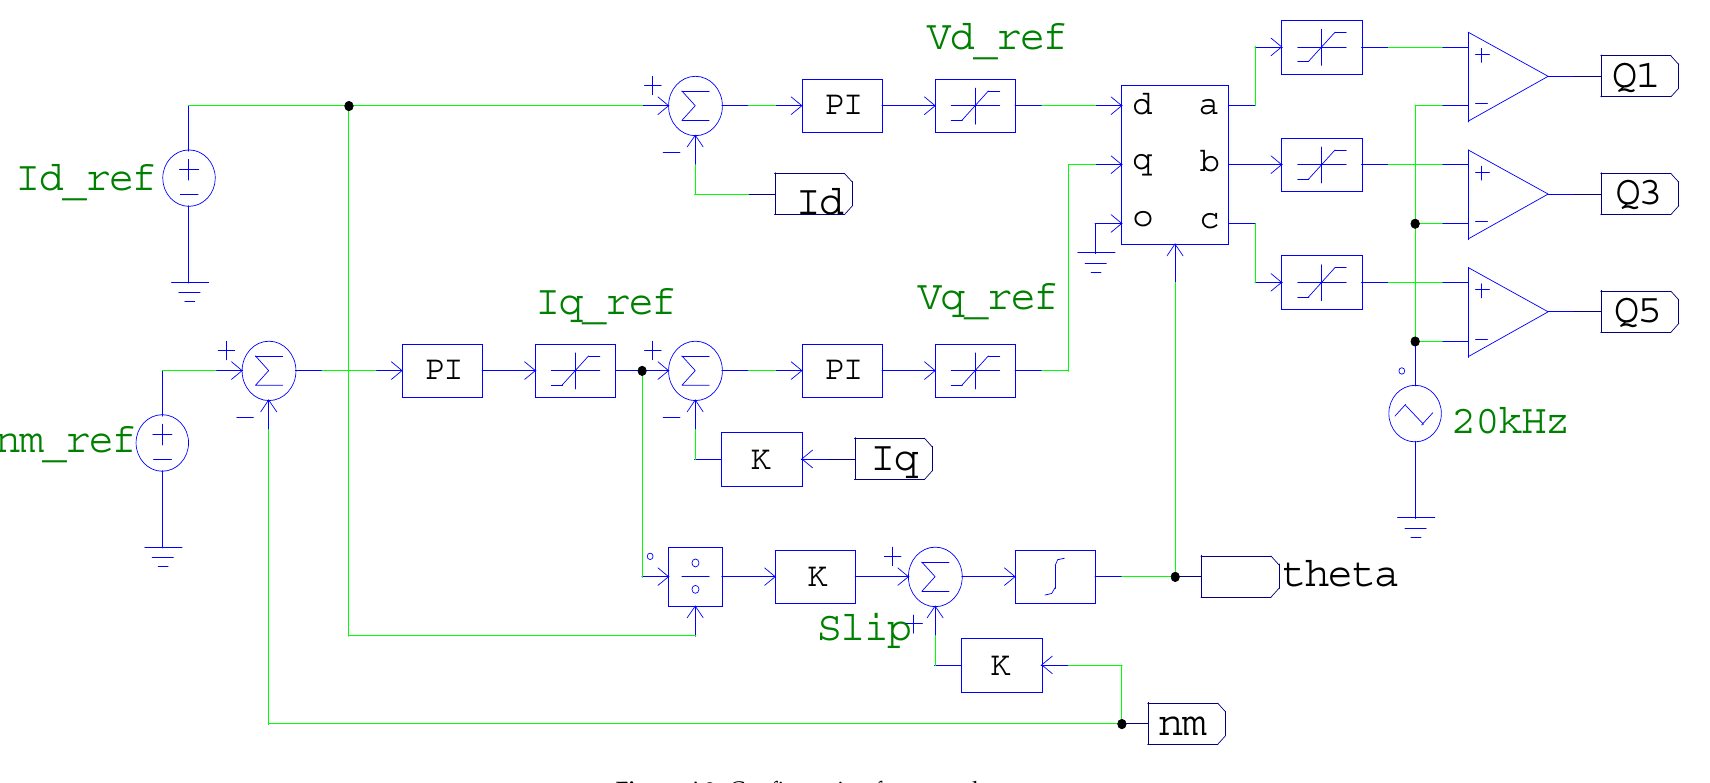
Figure A3. Configuration for control